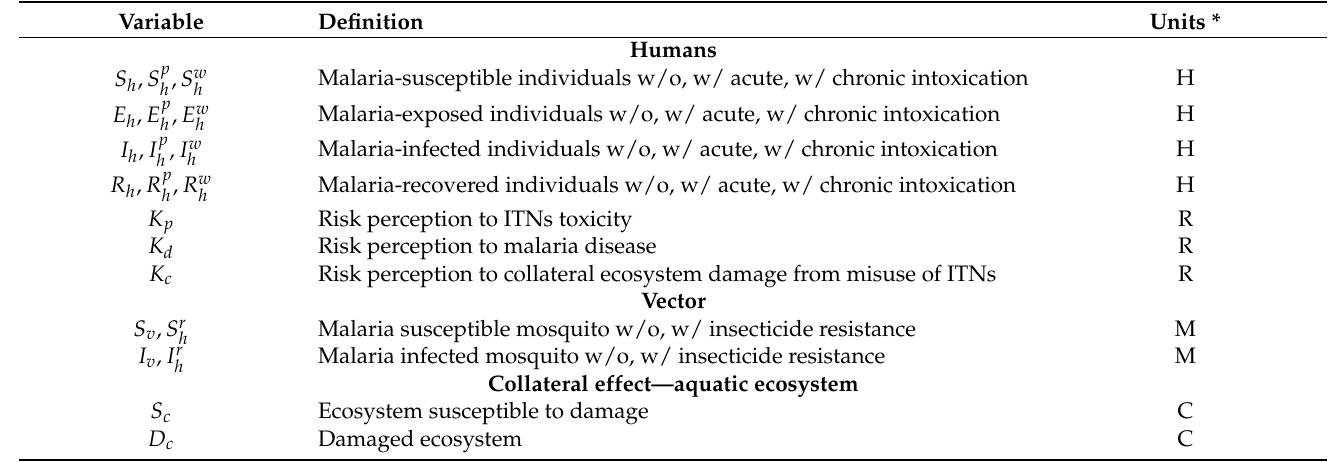
Table 1. Description of variables for the model given in system (5).